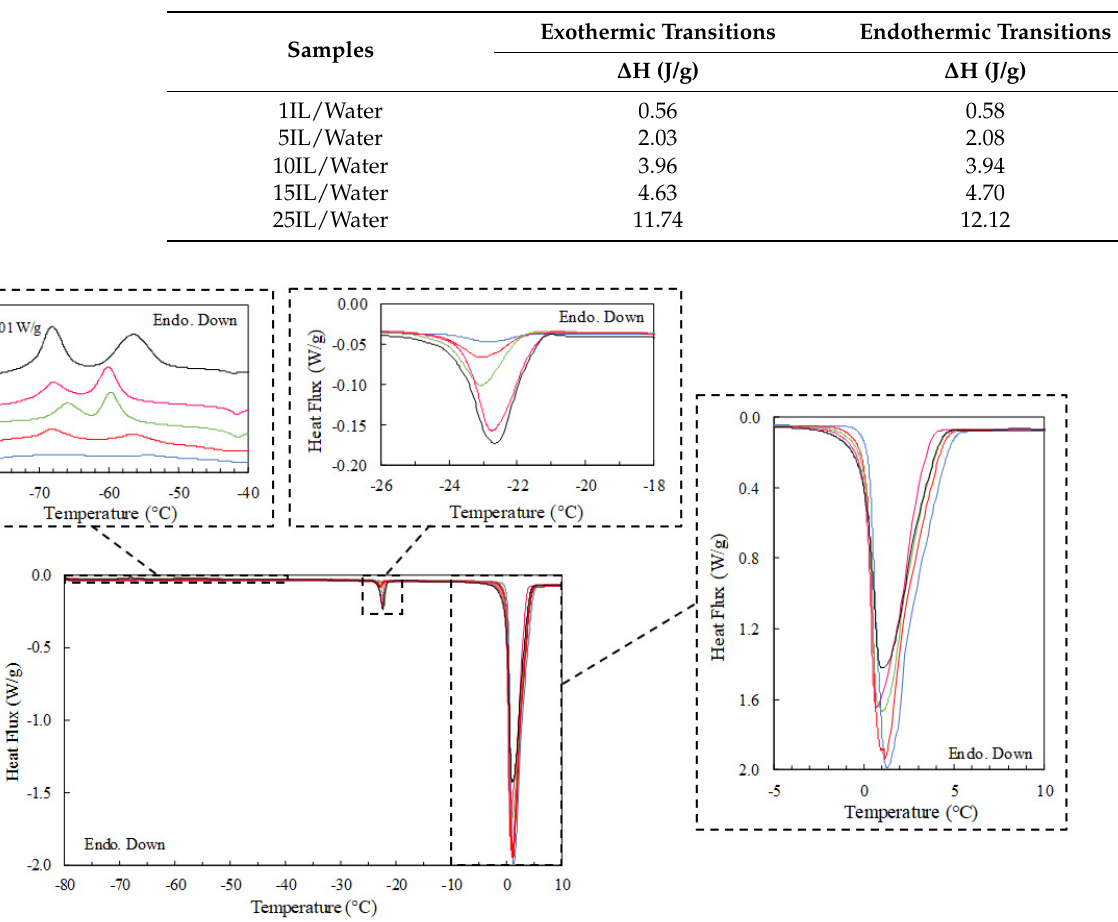
Table 4. Accumulative enthalpies are associated with either endothermic or exothermic transitions of IL/Water mixtures in the temperature range between − 80 and − 15 ◦ C.